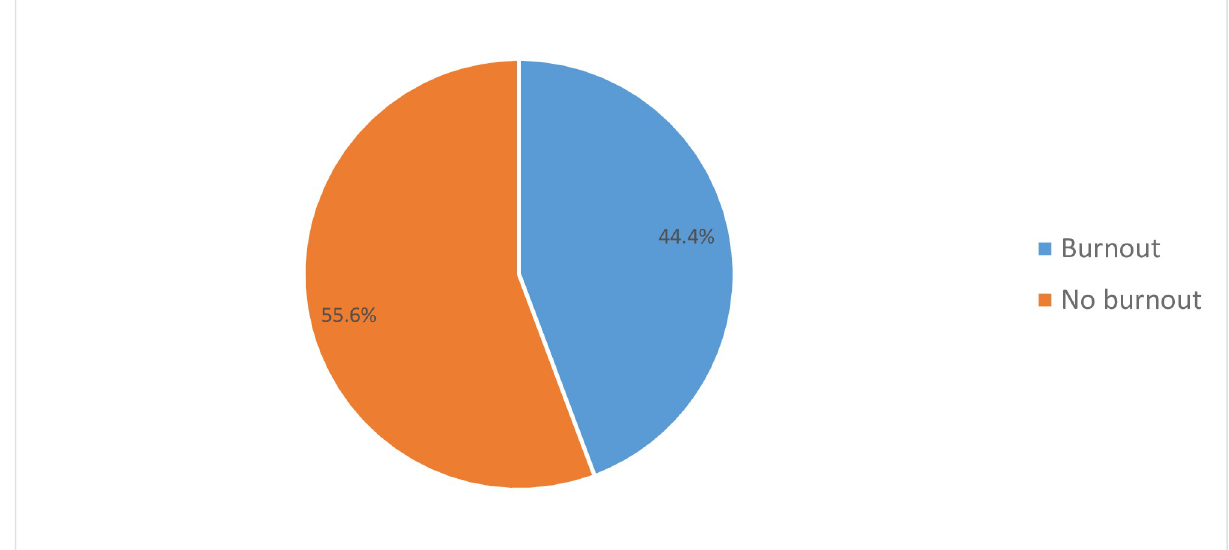
Fig 2. Magnitude of burnout among nurses who were working in Harari regional state and Dire Dawa administration, Ethiopia, 2020.